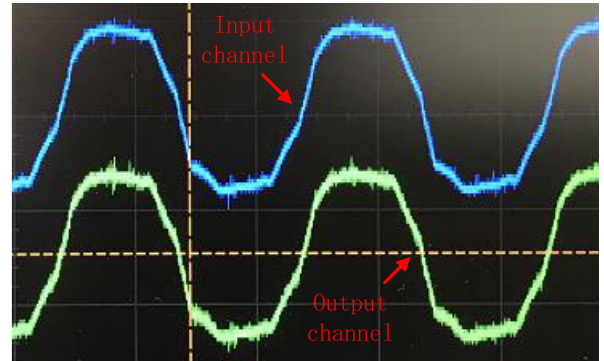
Figure 8. The circuit of the multi-channel analog adder with limiting function.